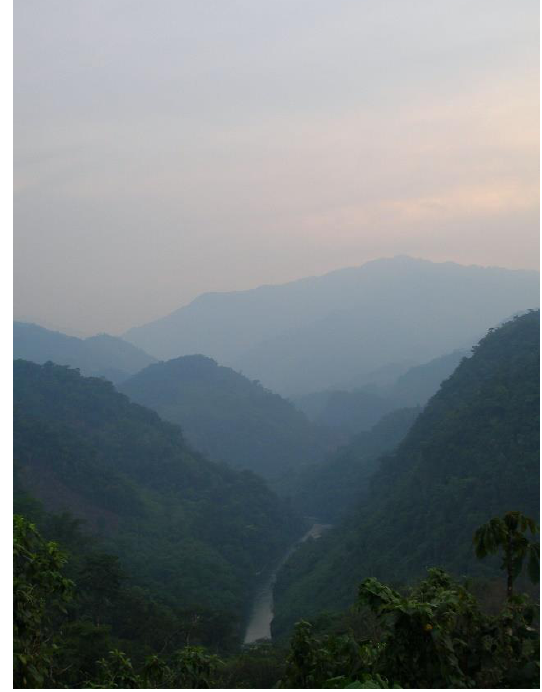
Figure 2. Chixoy river (credits Lieselotte Viaene, 2007).